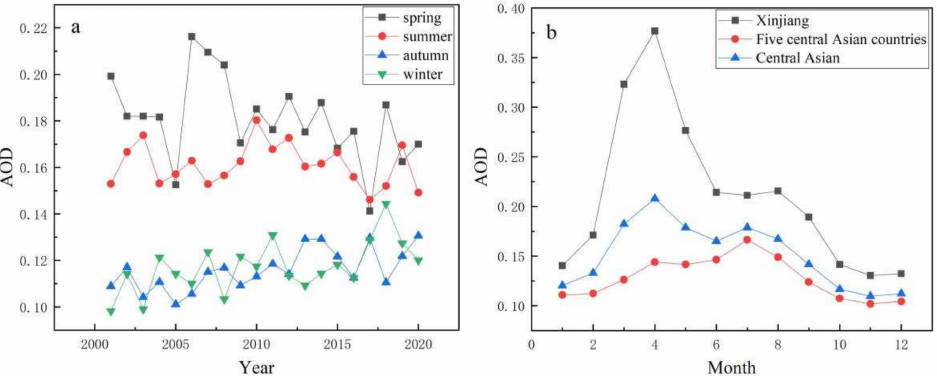
Figure 10. Annual variation of AOD in Central Asia, ( a ) variation of AOD in different seasons; ( b ) Change of AOD in different